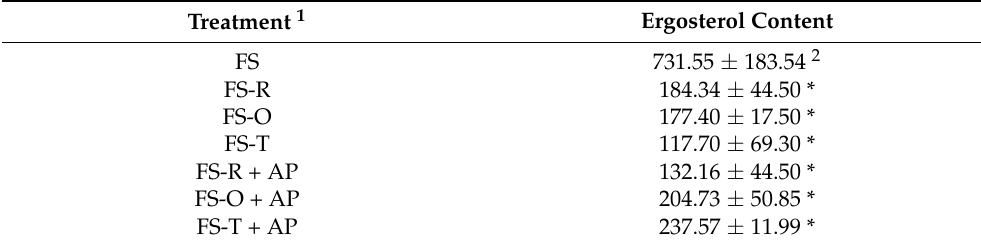
Table 5. Effect of rosemary, oregano, and thyme on the ergosterol content ( µ g/g of mycelium) of Penicillium nordicum CBS